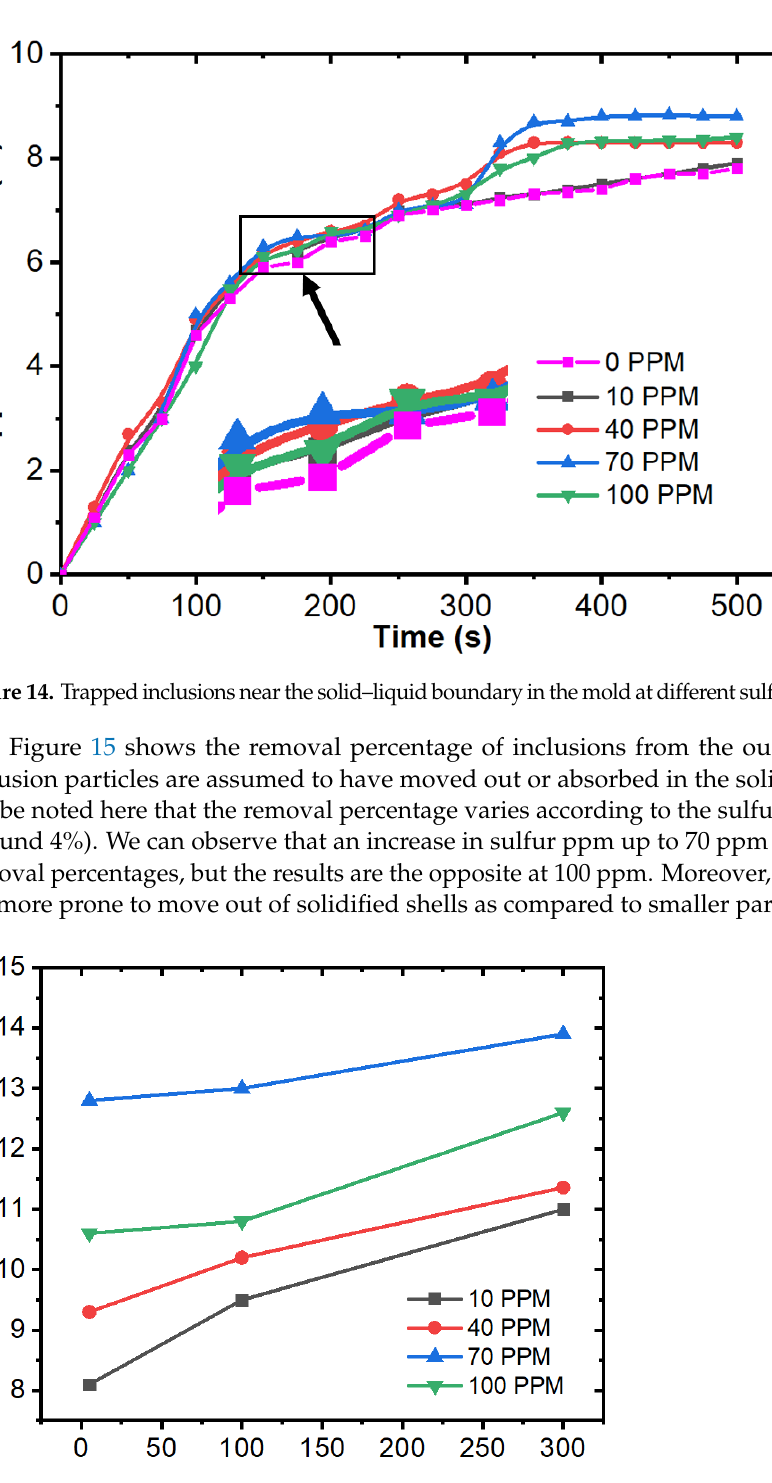
Figure 15. Removal percentage of alumina inclusions in different conditions of sulfur concentration and inclusion diameters.